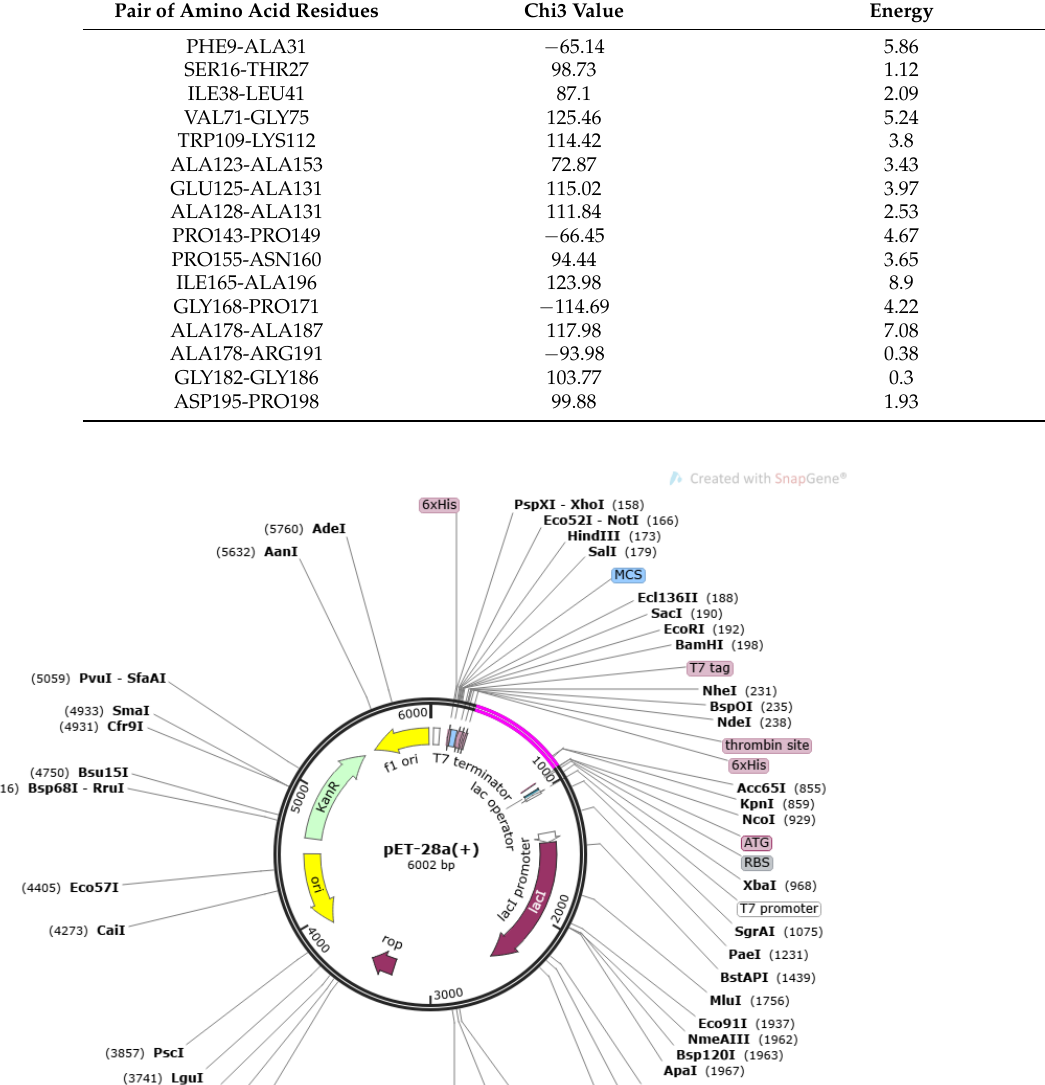
The secondary structure was predicted using the PDBsum generate tool as shown in